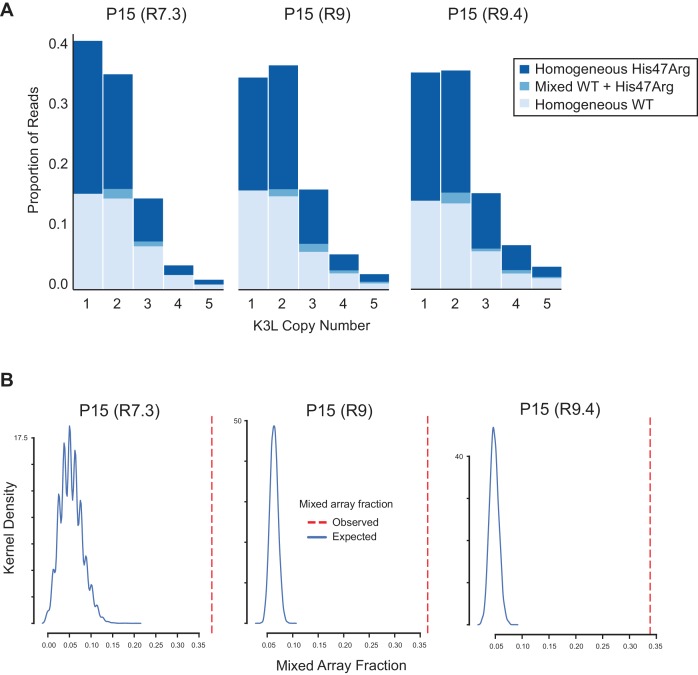
ONT sequencing error rates do not affect observed proportions of homogeneous and mixed K3L arrays.(A) Using reads from passage 15 populations sequenced with R7.3, R9, and R9.4 flowcell chemistries, all mixed arrays were converted into homogeneous arrays (see Materials and methods for further detail). K3LWT and K3LHis47Arg alleles were then switched as a proxy for sequencing errors, and the proportions of mixed arrays recovered were calculated. Stacked bar plots representing the proportions of mixed and homogeneous arrays were then generated following one simulation. (B) Kernel density plots were also generated, representing the distributions of expected mixed array proportions recovered across 1000 simulations. The observed proportion of mixed arrays using the indicated flowcell chemistry is shown as a dotted red line.